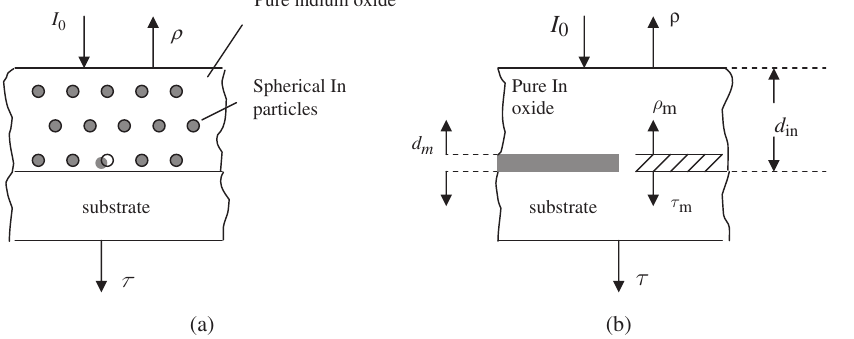
Figure 1: (a) Indium-embedded indium oxide film on a glass substrate with the reflectivity and the transmittivity ρ and τ , respectively. (b) Optically equivalent film system. d m is the equivalent metallic film thickness and d in is the interferometrically measured thickness of the original sample. ρ m and τ m are the reflectivity and transmittivity of the thin metallic indium film,